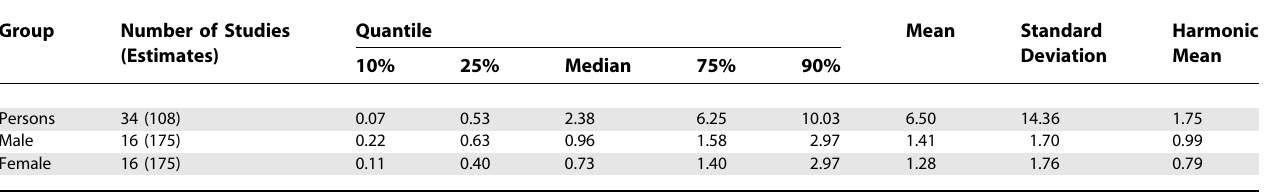
Table 7. Quantiles and Moments of Studies with Inpatient-Census-Derived Data per 1,000 by Sex Group Number of Studies